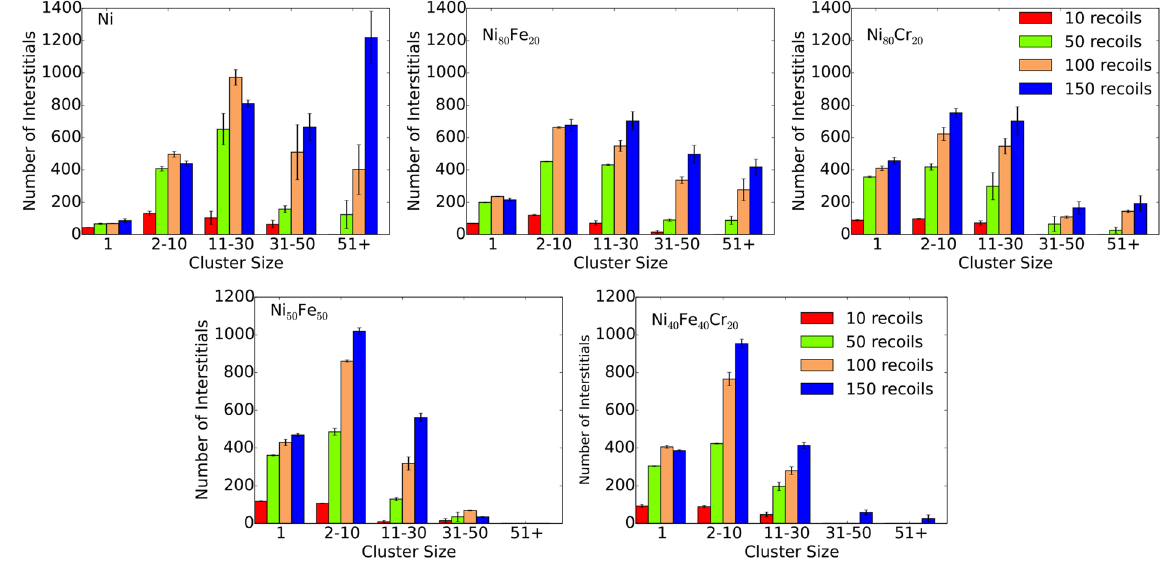
Figure 5. Interstitial cluster size distribution at different recoil events. Comparison of interstitial cluster size distribution between Ni,